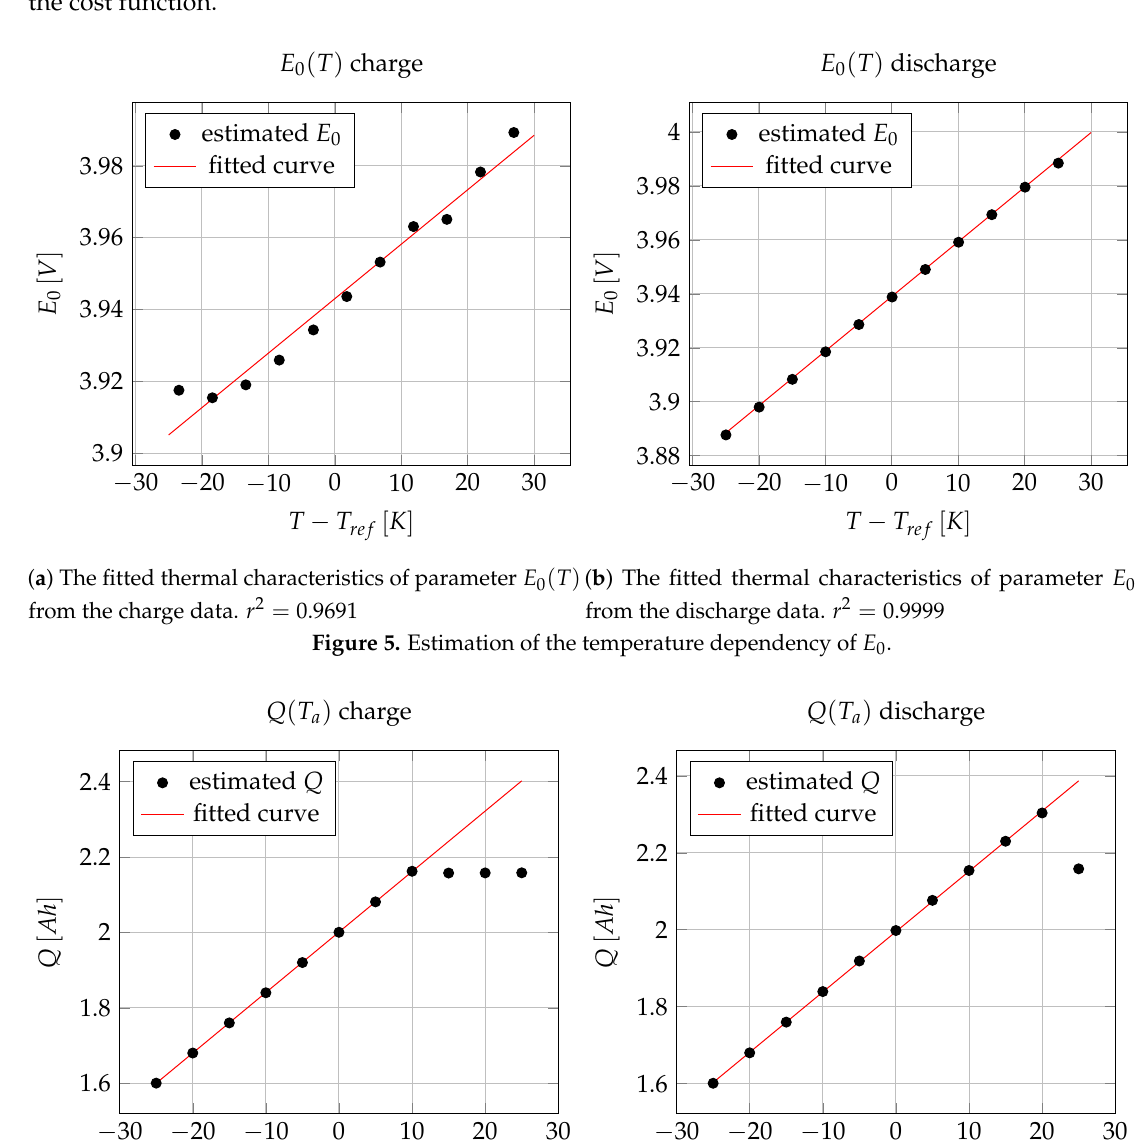
Figure 6. Estimation of the temperature dependency of Q